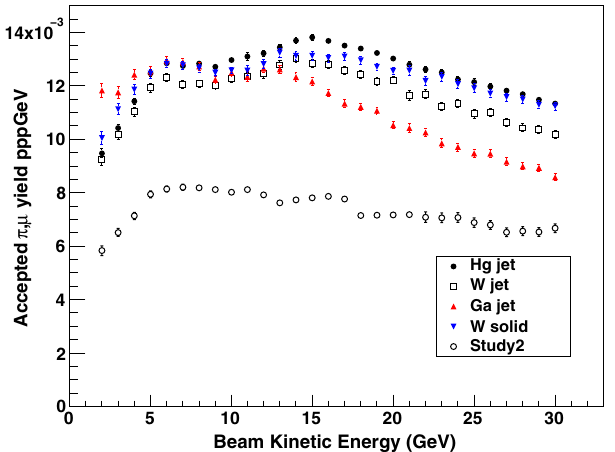
FIG. 7. Distribution of the deposited energy density (J/cc) per beam pulse (50 Hz repetition rate) in the improved shielding geometry configuration for the mercury jet target. Also shown is the estimated power deposition within various regions (blue italics denote the power deposited in the beam pipe).